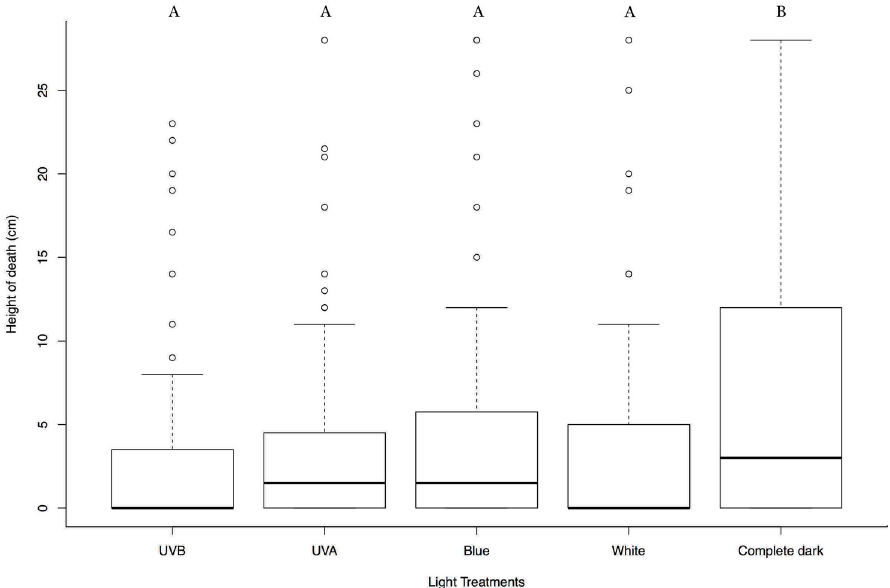
Figure 2. Box plots summarizing the vertical position of the HearNPV infected H. armigera larvae at death in different light treatments from below. Y-axis represents the vertical position of the dead larvae from the base of the cylinder in centimeters (cm); X-axis represents different light treatments; In each box plot, the heavy horizontal line crossing the box is the median, the bottom, and top of the box are the lower and upper quartiles, the whiskers are the minimum and maximum values, and the dots are the outliers. Clusters with the same letter code are not significantly different.